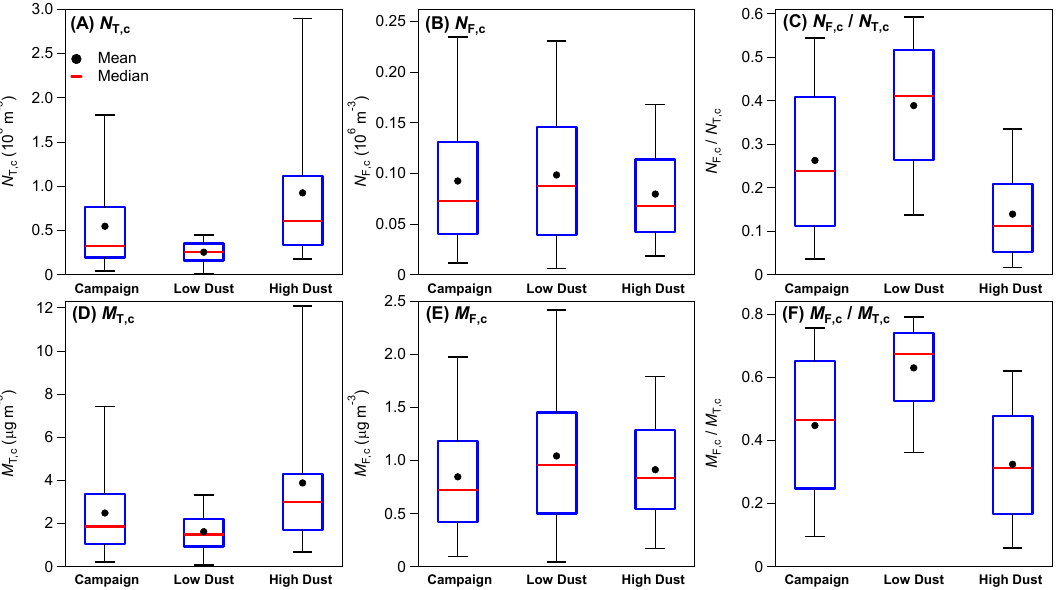
Fig. 4. Statistical distribution of integrated coarse FBAP and total number and unit-normalized mass concentrations (1–20µm) for each of three periods: entire campaign, low dust focus period, high dust focus period. (A) N T , c , (B) N F , c , (C) N F , c / N T , c , (D) M T , c , (E) M F , c , (F) M F , c / M T , c .